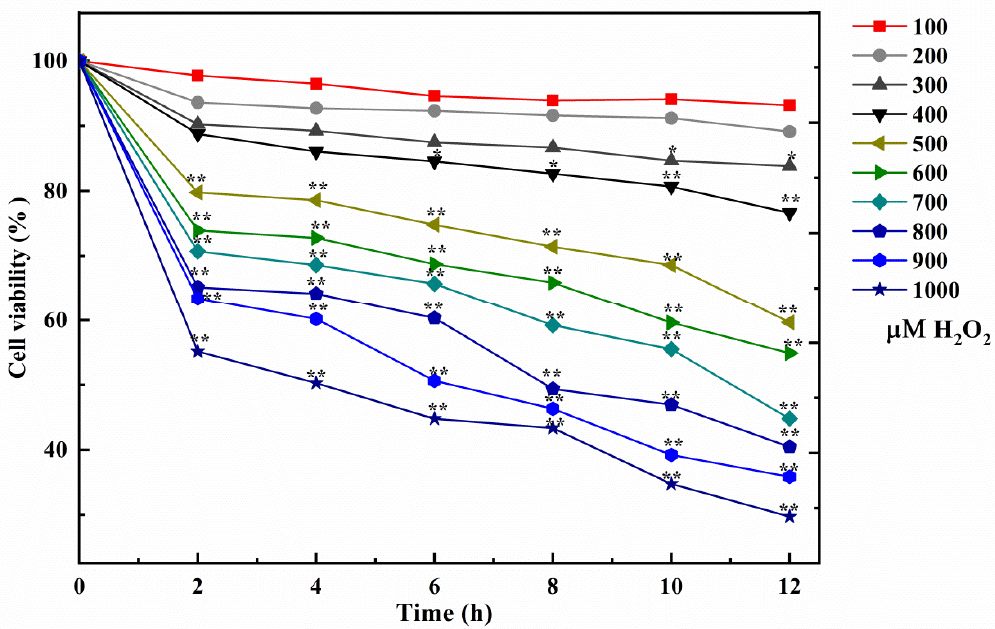
Figure 1. Effect of H 2 O 2 on the survival rate of NCTC-1469 cells ( n = 6). Results are expressed as means ± SD ( n = 6), * p < 0.05, ** p < 0.01.